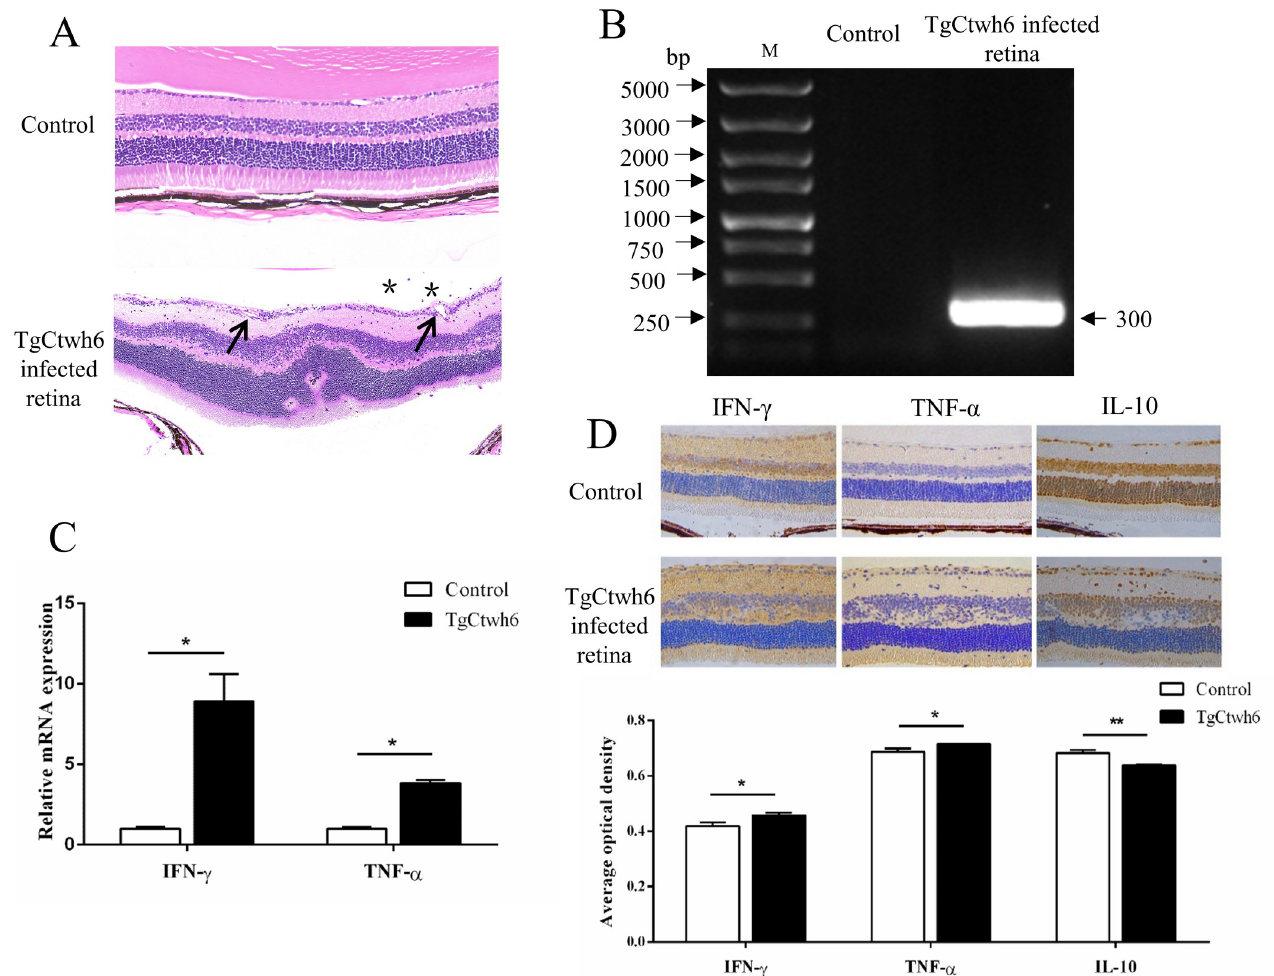
Fig 1. Histopathological changes in ocular tissues infected with the TgCtwh6 strain. Uninfected mice; infected mice at Day30. (A)Retina of a control eye from normal non-infected mice showing the normal architecture. All layers are present and unaltered. General aspect of TgCtwh6 infected retina showing the alteration of the retinal layer. Inflammatory cells were seen in the vitreous ( � ). Retinal vasculitis (black arrowhead) was evident and disorganization of the retinal architecture. Original magnification 400 × , H&E stain. (B)Toxoplasma-ITS-1 PCR results, M: DNA Marker, n = 10 mice. (C)The mRNA expressions of IFN- γ and TNF- α in ocular tissues of naive mice and T . gondii -infected mice were measured by using a Real-time quantitative PCR. GAPDH was used as an internal control. The data were analyzed using Mann Whitney U test. mean ± SEM, � p < 0.05. (D)Representative experimental retinas stained for IFN- γ , TNF- α and IL-10 from control and OT murine model by immunohistochemistry as described in the Methods. 400 × . Quantification of IFN- γ , TNF- α and IL-10 expression levels in retinas by the software Image J. Values represent the mean ± SEM, � P < 0.05, �� P < 0.01.